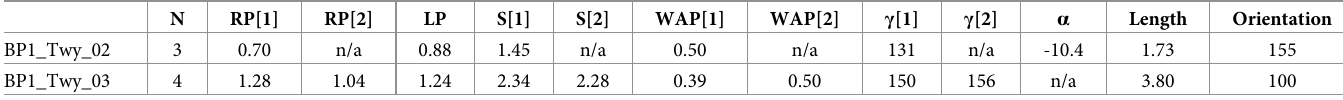
Table 2. BP1 bipedal trackway measurements.